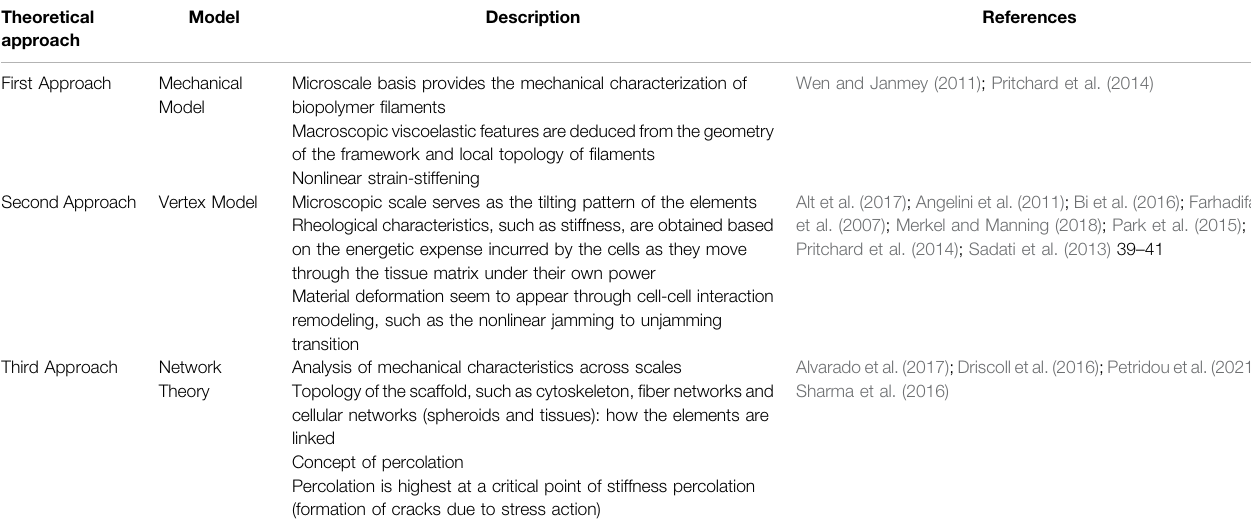
TABLE 1 | Three theoretical approaches to describe the discrepancy between macroscopic and microscopic mechanical characteristics of